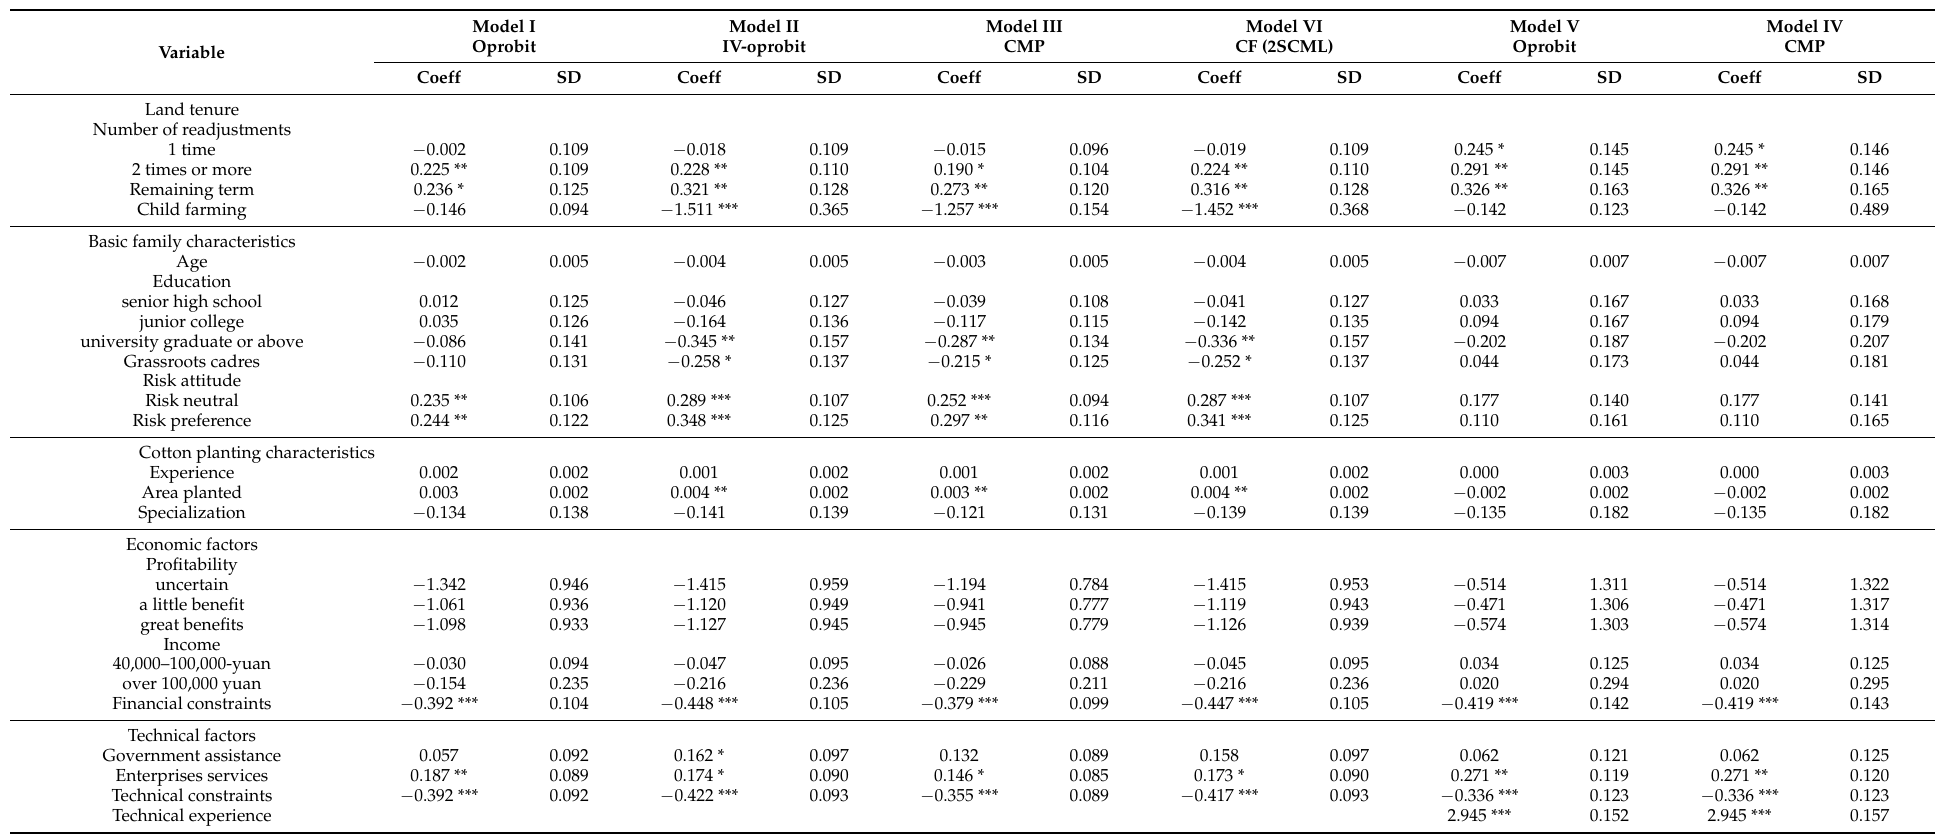
Table 5. Determinants of land improvement